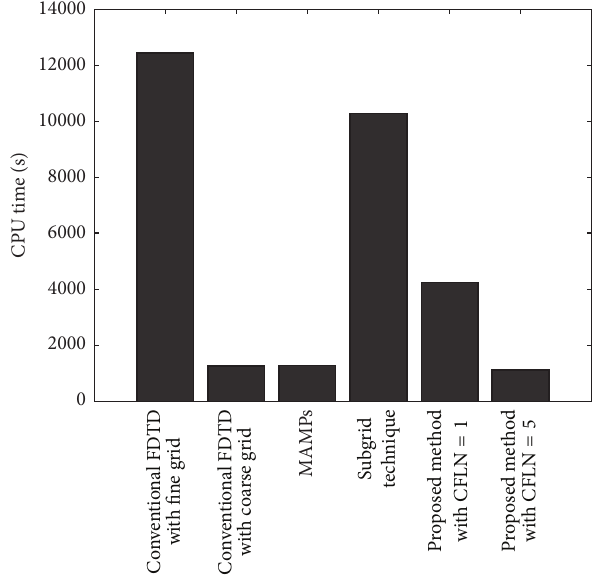
Figure 10: CPU time using different